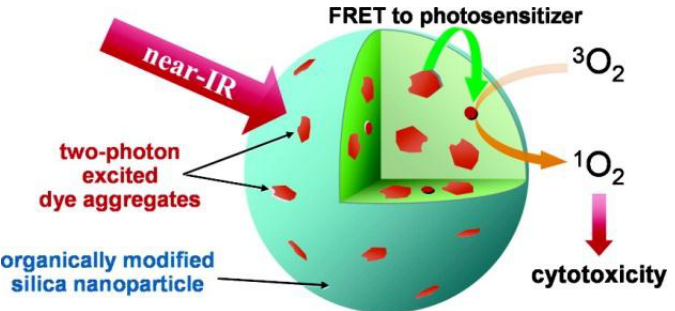
Figure 7. Schematic illustration of organically-modified two-photon photodynamic therapy SiNPs. Reproduced with permission from [74]. Copyright 2007 American Chemical Society.